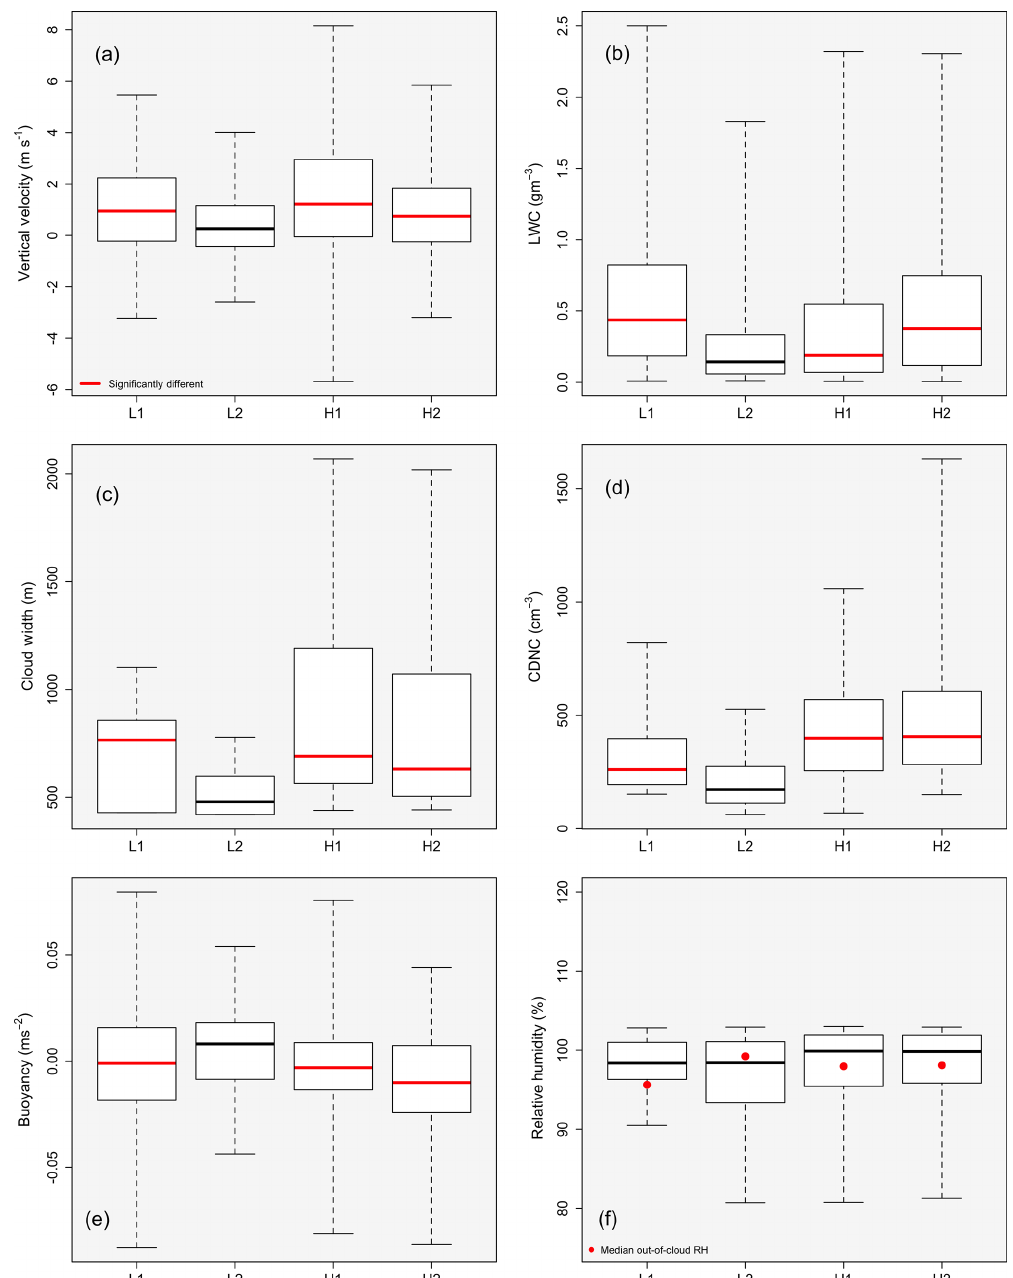
Figure 11. Box plots of L1, L2, H1, and H2, represented in that order on the x axis, with panels (a) through (f) representing vertical velocity data sets that are statistically significant as compared to the L2 data set. Each red dot in panel (f) represents out-of-cloud